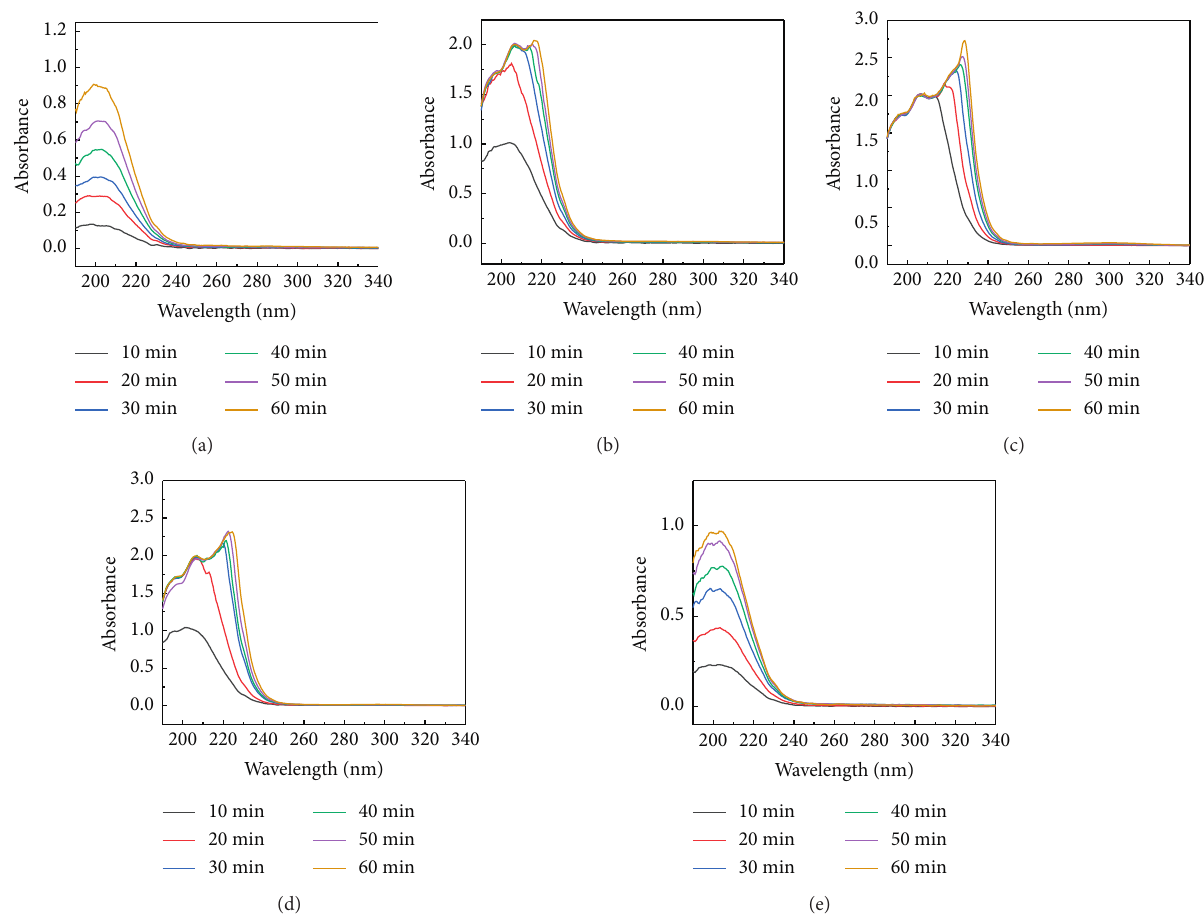
Figure 10: UV/Vis spectra at the needle-dielectric plate distance of 4 cm and voltages of (a) 15, (b) 20, and (c) 25kV. UV/Vis spectra at a voltage of 20kV and the needle-dielectric plate distance of (d) 3 and (e) 5 cm.